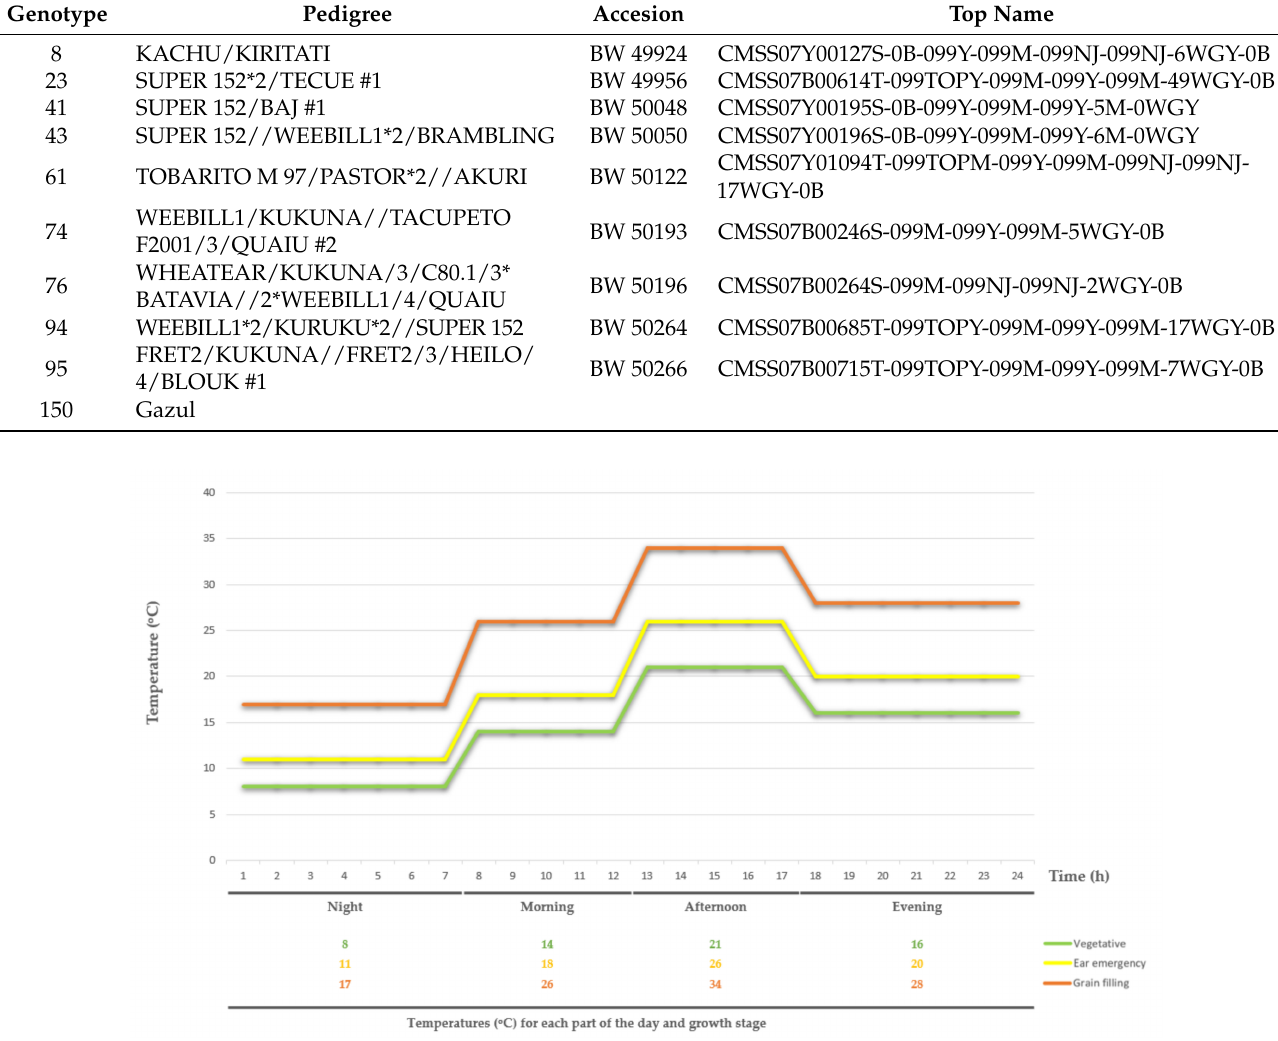
Figure A1. Schematic representation of the daily and seasonal oscillations of temperatures simulated throughout wheat